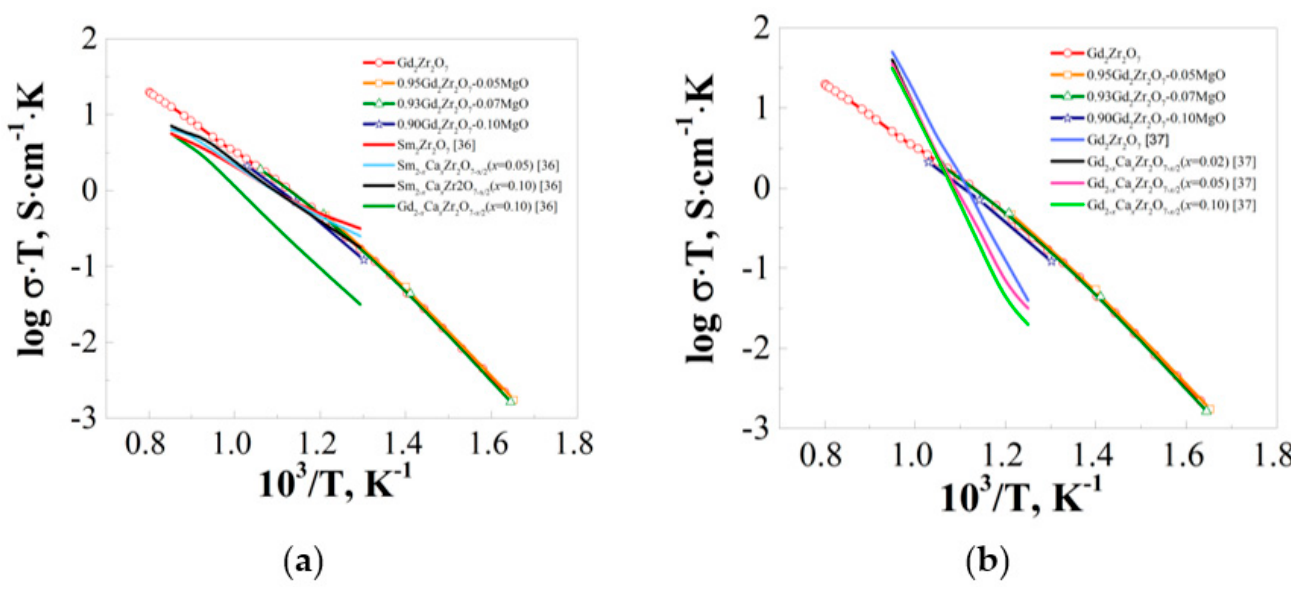
Figure 7. Temperature dependence of bulk electrical conductivity for the (1- x )Gd 2 Zr 2 O 7 · x MgO composites, Sm 2- x Ca x Zr 2 O 7- x /2 ( x = 0, 0.05, 0.10) [36], and Gd 2- x Ca x Zr 2 O 7- x /2 ( x = 0.10) [36]. ( a ) Temperature dependence of bulk electrical conductivity for the (1- x )Gd 2 Zr 2 O 7 · x MgO composites and Gd 2- x Ca x Zr 2 O 7- x /2 ( x = 0, 0.02, 0.05, 0.10) [37] ( b ).